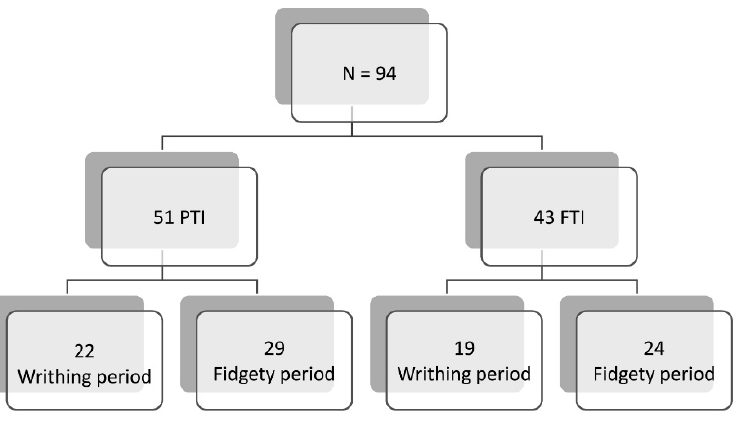
Figure 1. Composition of the four groups of study.